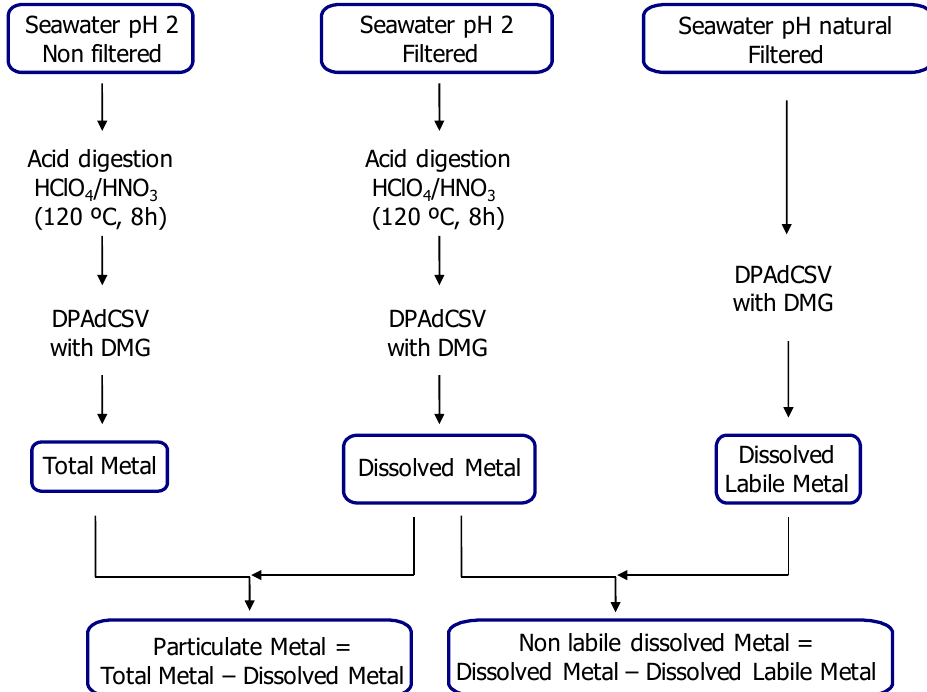
Figure 3. Scheme of chemical fractionation of Ni and Co in water samples.